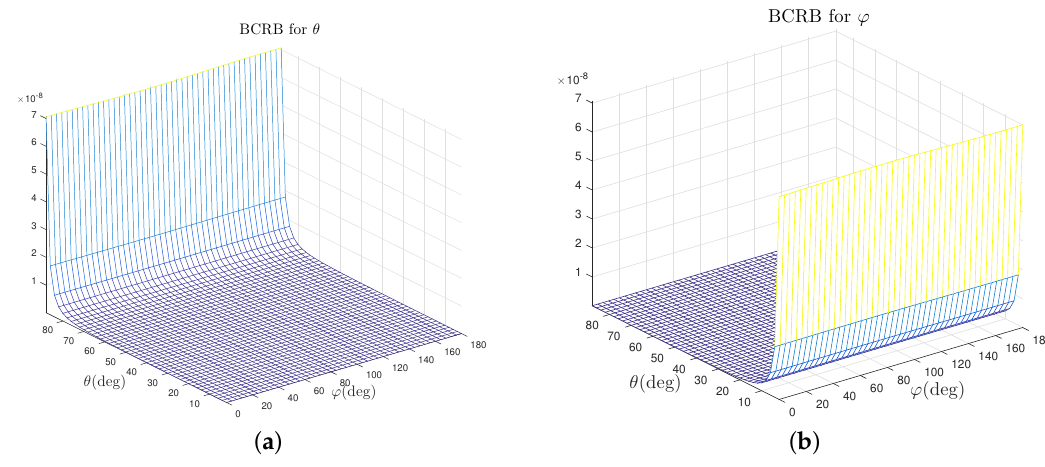
Figure 8. Bayesian Cramér-Rao Bound (BCRB) for off-grid bias estimation: ( a ) BCRB for θ . ( b ) BCRB for ϕ .